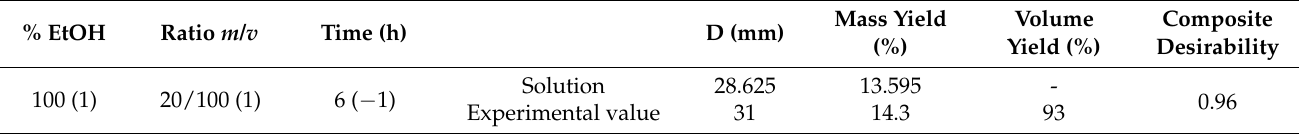
Table 4. Optimal extraction conditions of active compounds from Enantia chlorantha bark and composite desirability of volume yield, mass yield, and inhibition